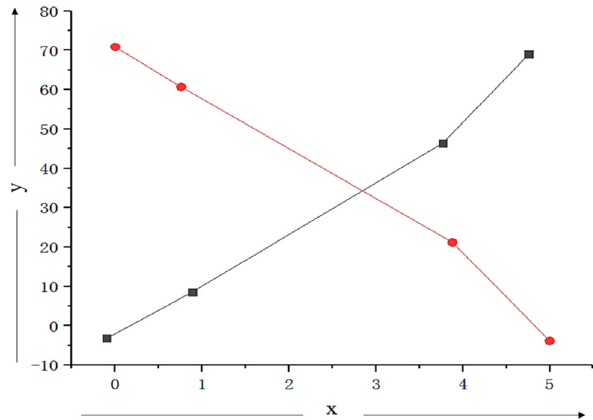
Figure 3: Ship motion reference coordinate system based on dynamic positioning control.